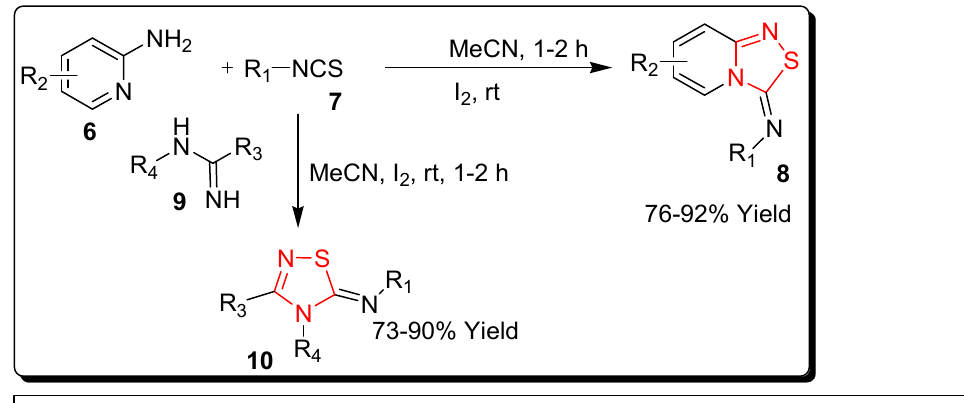
Scheme 3. Regio-specific synthesis of 3,4-disubstituted 5-imino-1,2,4-thiadiazole hybrids 8 , 10. 5.4. Molecular I 2 Catalysis for One-Pot Green Protocol and Intramolecular Oxidative Coupling